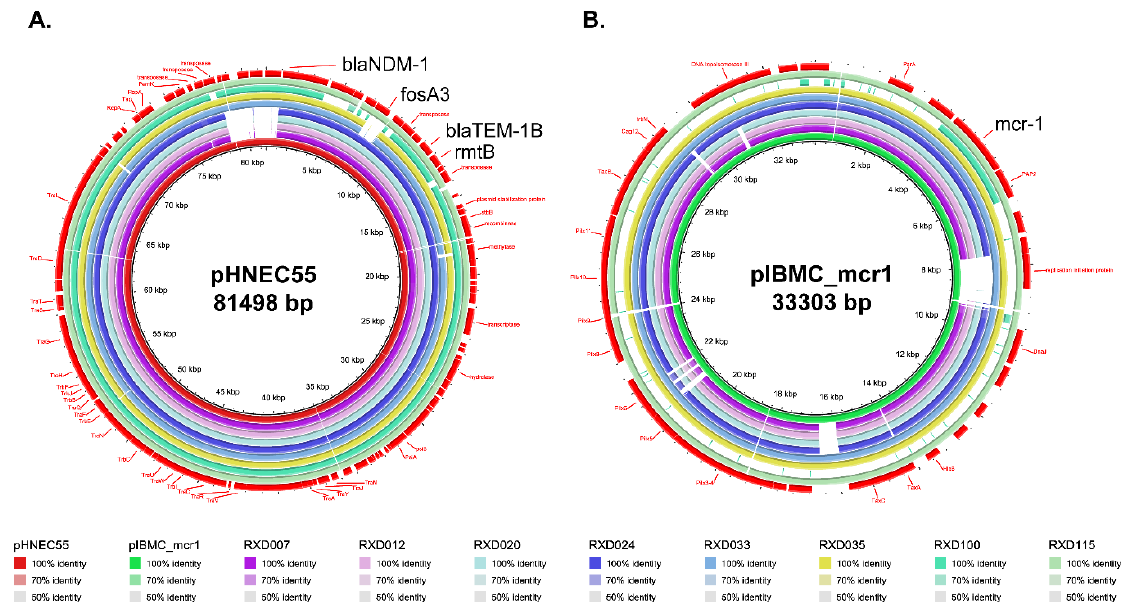
Figure 5 . Comparison of plasmid pHNEC55 (panel A) and pIBMC_mcr1 (panel B) with the genomes of RXD007, RXD012, RXD020, RXD024, RXD033, RXD035, RXD100, and RXD115, displayed as the outer rings inside to outside, respectively. The outmost rings (red) show the functional genes including the resistance genes as well as the structural genes carried by pHNEC55 (panel A) and pIBMC_mcr1 (panel B).